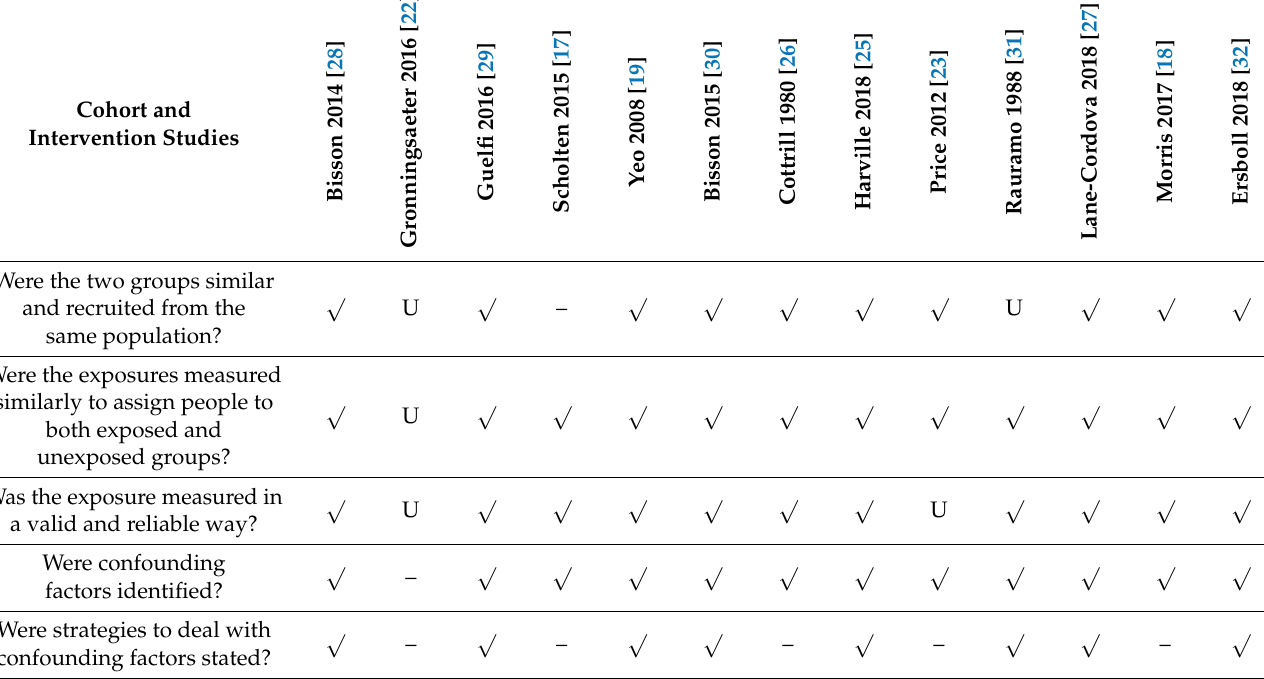
Table 2. Study quality ratings based on Briggs Institute Critical Appraisal